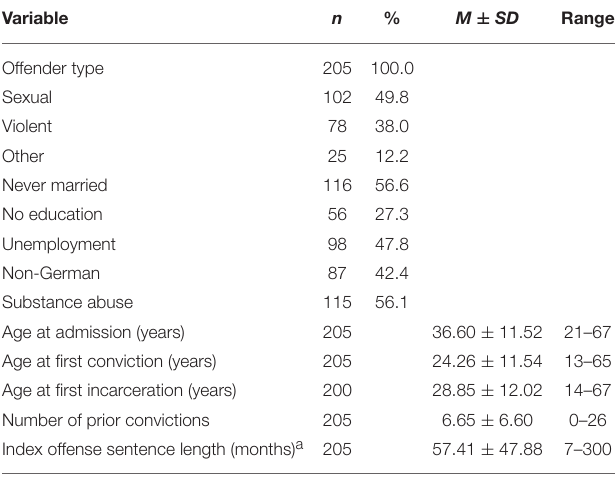
TABLE 1 | Demographic and criminological